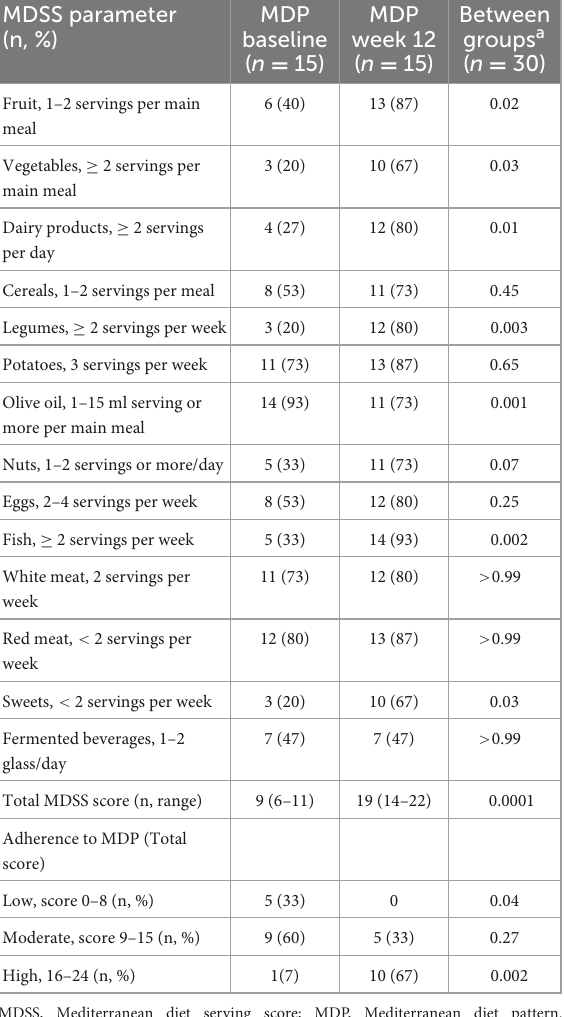
TABLE 3 The Mediterranean diet serving score for the Mediterranean diet pattern and Canada’s habitual diet at week 12. MDSS parameter (n, %)